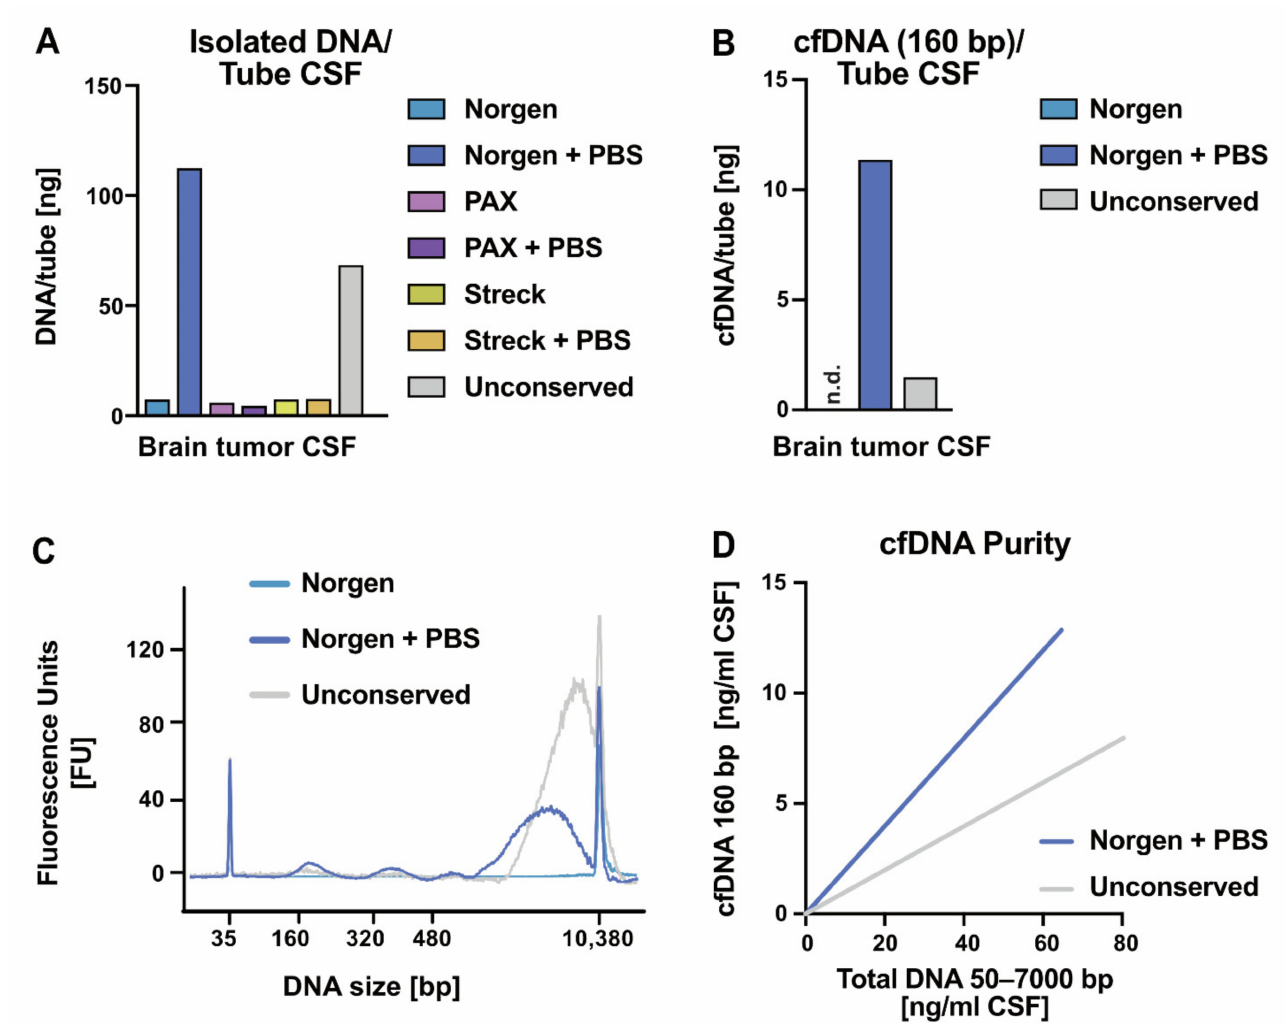
Figure 2. Strategies for CSF conservation in blood preservation tubes. ( A ) Concentration of total DNA recovered from 1.5 mL CSF of a brain tumor patient conserved in the indicated tube type. DNA was isolated with NucleoSpin, and the DNA concentration was measured by Qubit. ( B ) The concentration of cfDNA (first nucleosomal peak, 160 bp) recovered from 1.5 mL CSF of a brain tumor patient conserved in the indicated tube for preservation and isolated by NucleoSpin. The concentration was determined by measuring the first peak of the Bioanalyzer profile (BA). n.d. indicates not detectable values. ( C ) BA profiles for DNA isolated from CSF of a brain tumor patient after 7 d unconserved (gray), in a Norgen tube (light blue), and a Norgen tube filled up with PBS before centrifugation (dark blue). ( D ) cfDNA purity of DNA isolations from unconserved CSF and CSF collected in a Norgen tube that was filled up with PBS. Purity was defined as the ratio of cfDNA (first nucleosomal peak, 160 bp) to total DNA (50–7000 bp) measured by